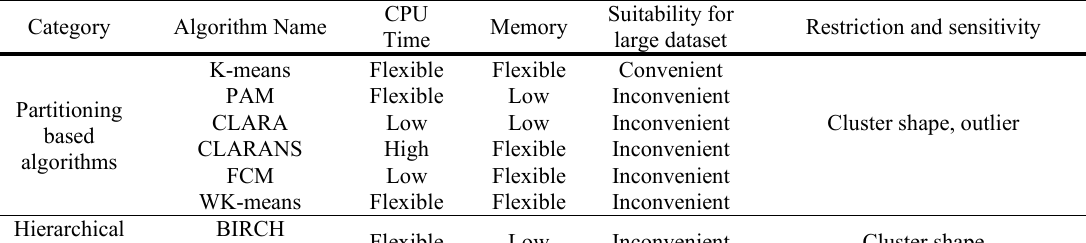
Table 6. Comparison of Clustering